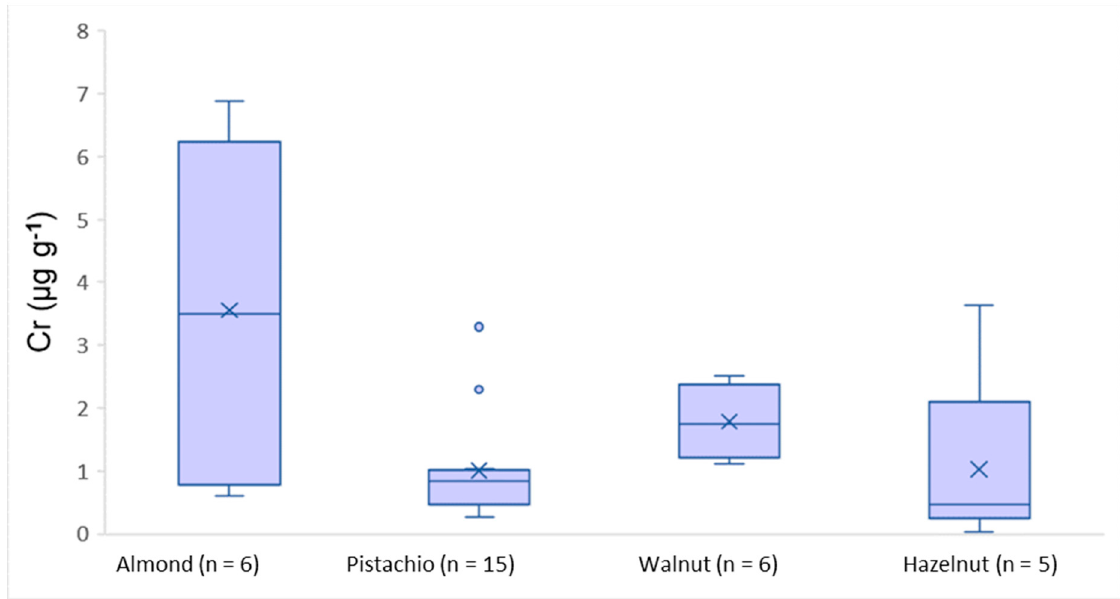
Figure 8. Box and Whisker plot for the concentrations of chromium among different nut species.